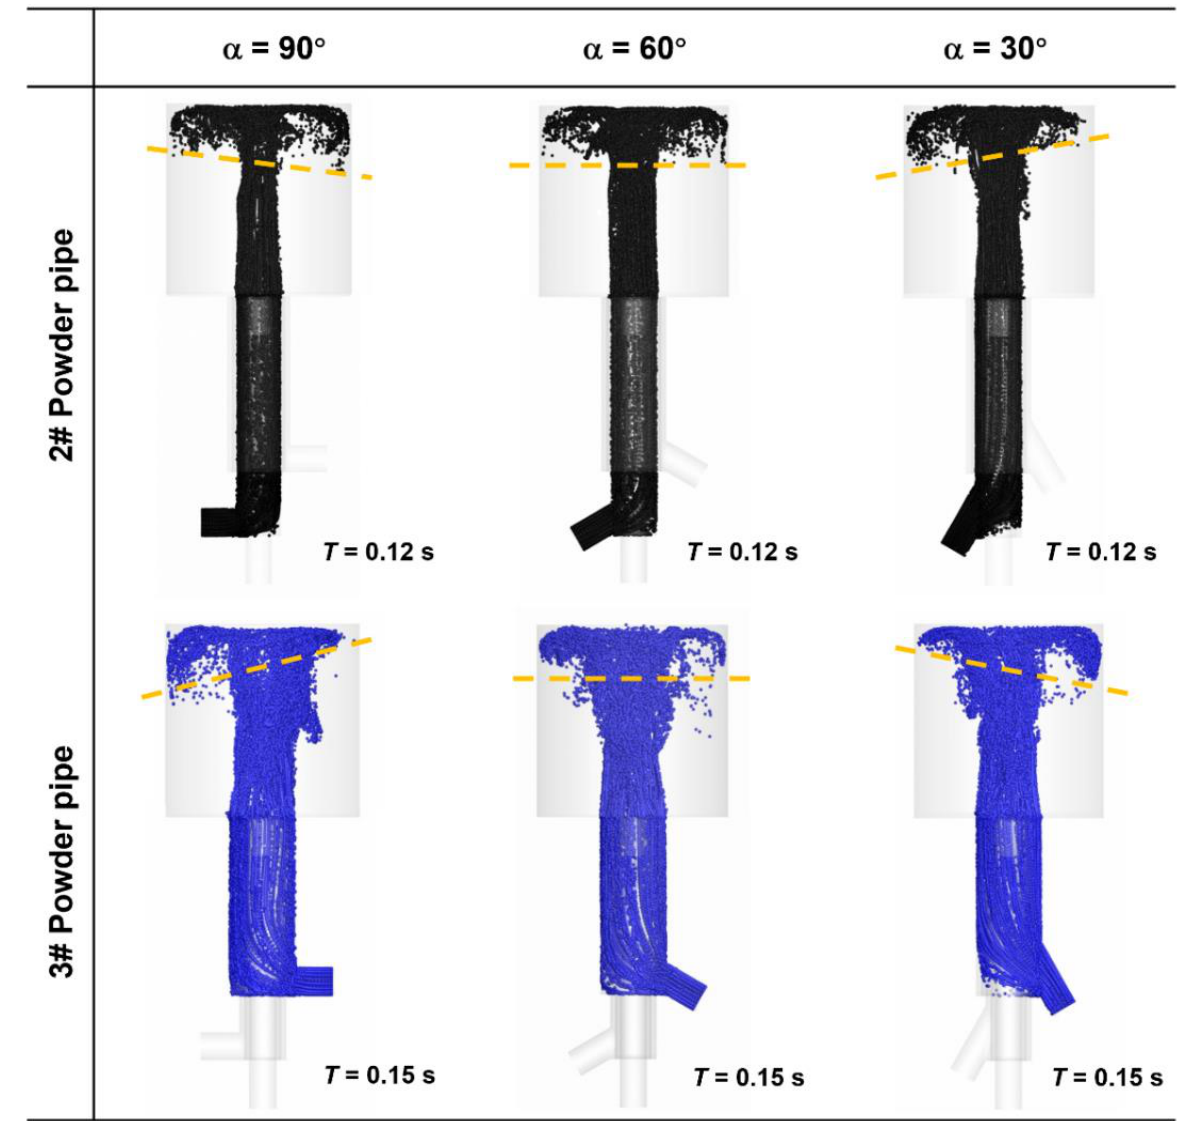
Figure 5. Particle distribution of the 2# and 3# powder conveying pipe.